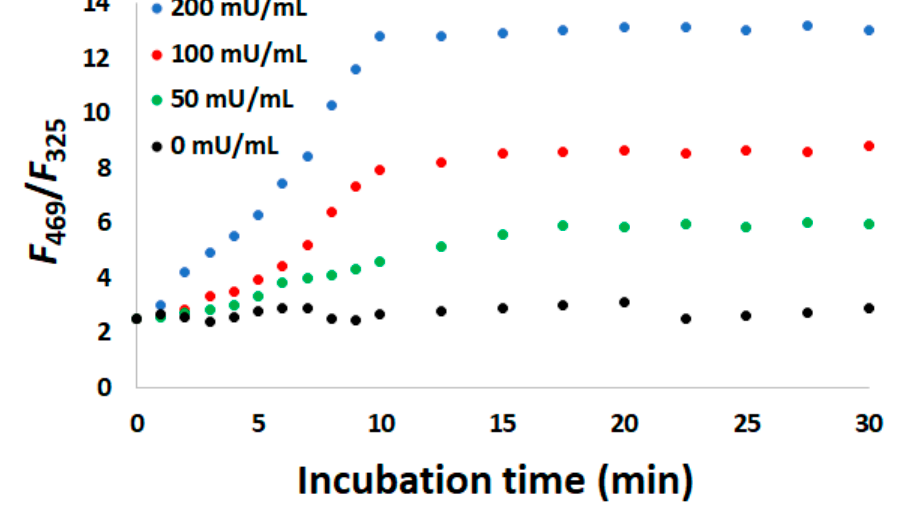
Figure 6. The variation in F 469 /F 325 ratio of probe 5 as a function of apyrase (ATPase) concentration and incubation time. [5] = 10 μ M, [ATP] = 20 μ M.